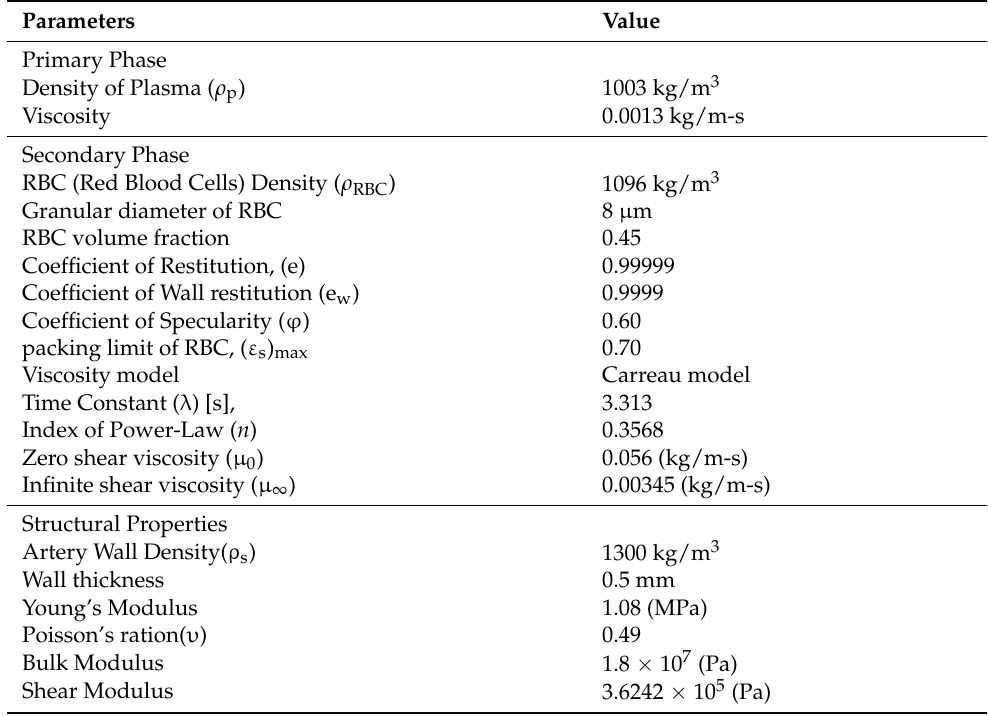
Table 1. Properties of blood plasma, RBC and structural properties of artery wall [16,24].